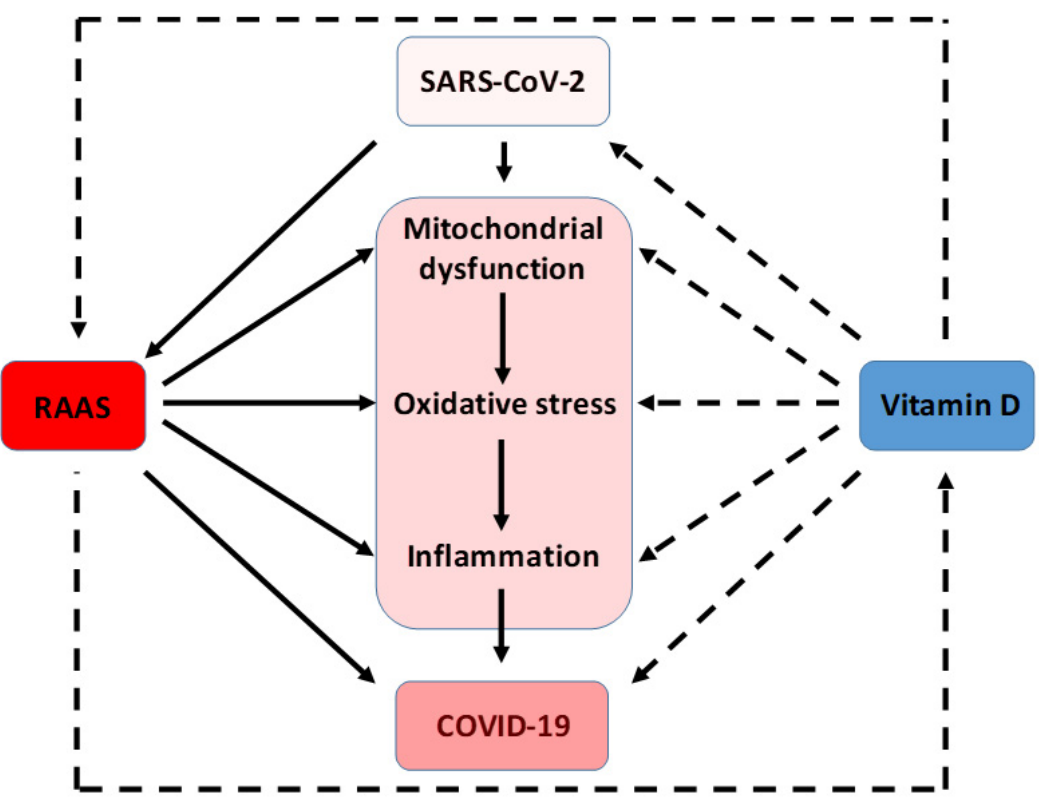
Figure 3. Interplay between mitochondrial dysfunction, RAAS over-activation, and vitamin D levels in the physiopathology of COVID-19. Solid lines indicate stimulation / induction, while dashed lines indicate inhibition /